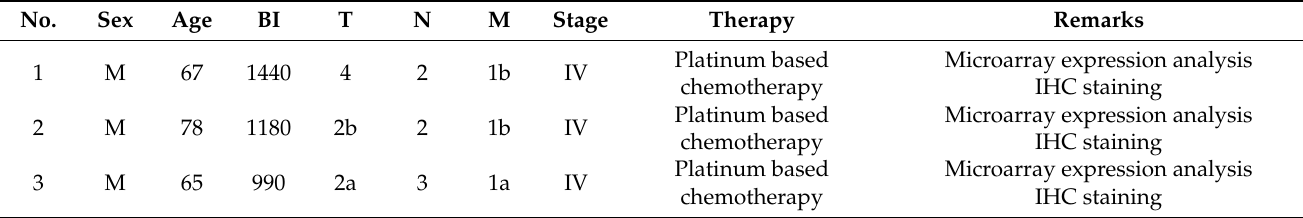
Table 1. Clinical features of the SCLC patients.